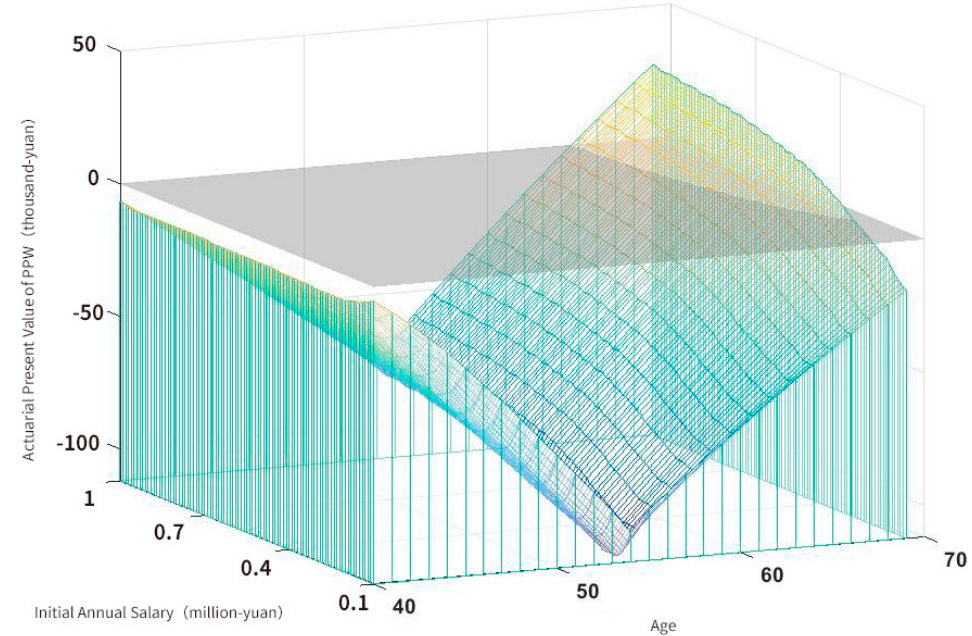
Figure 10. The impact of different initial annual salaries of 40-year-old insured women on the present value of PPW.